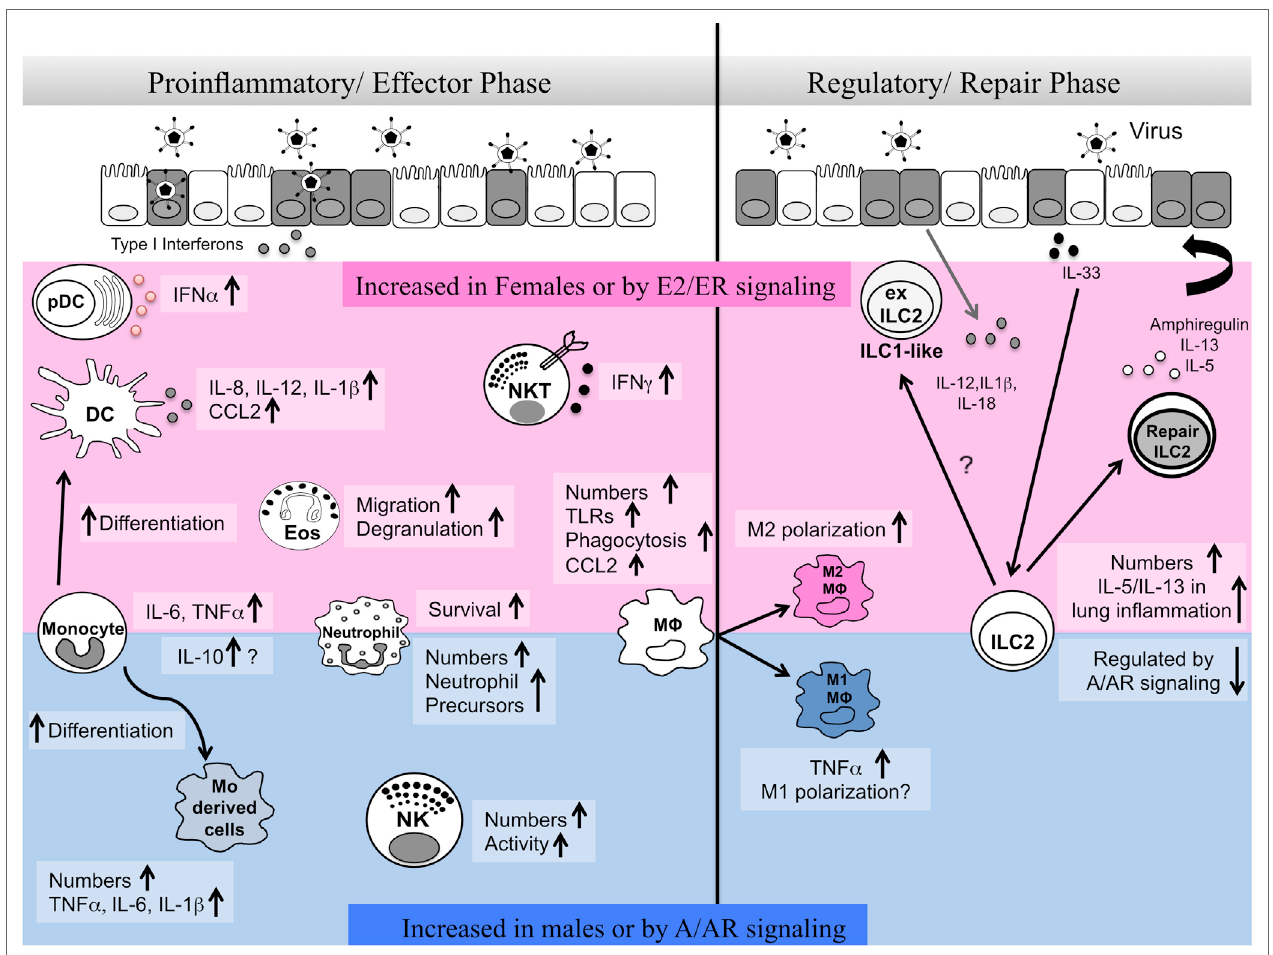
FiGURe 1 | Sex differences in innate immune responses during the effector and repair phases of respiratory virus infection. Here, we summarize reports of sex differences or sex hormone receptor regulation of innate immune cells. The pink shaded area indicates cells and pathways reported to be elevated in females and/or upon estrogen/ER activity. The blue shaded area indicates cells and pathways reported to be increased in males and/or upon androgen/AR activity. A balanced type 1 immune response involving different innate immune cells is required early post-infection in the lung for viral clearance. At later stages of infection, regulatory immune responses mediated by alveolar macrophages and innate lymphoid cells are important for the repair of damaged tissues and renewal of barrier integrity. Sex differences in numbers, functional responses, plasticity, and survival of innate immune cells regulate the proinflammatory/effector and regulatory/repair phases of